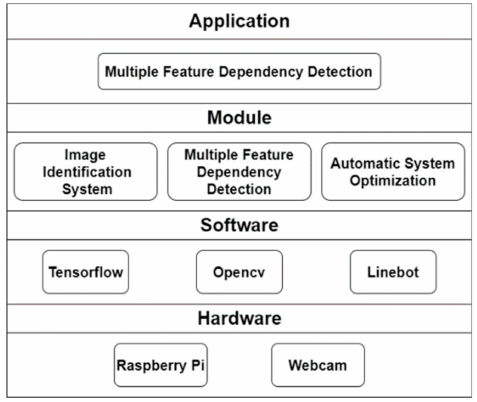
Figure 3. Functions of the smart pet surveillance